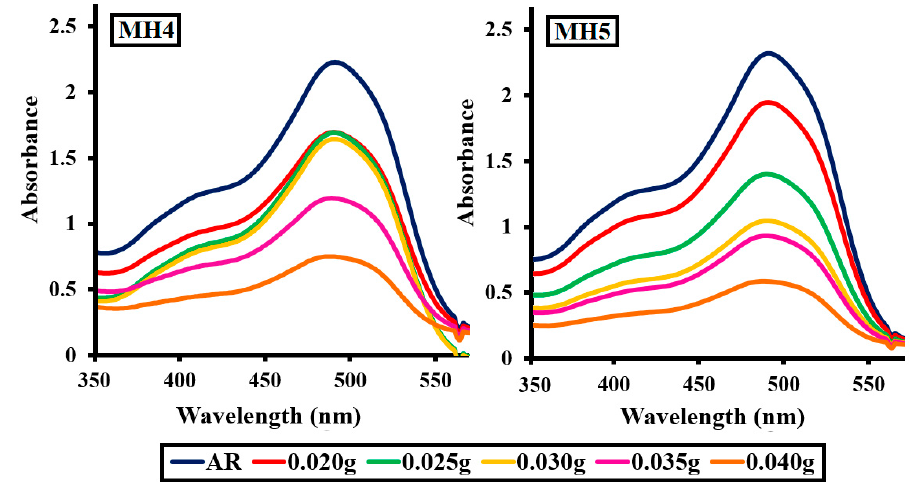
of MH1–MH5 after 60 min of photocatalytic activity.